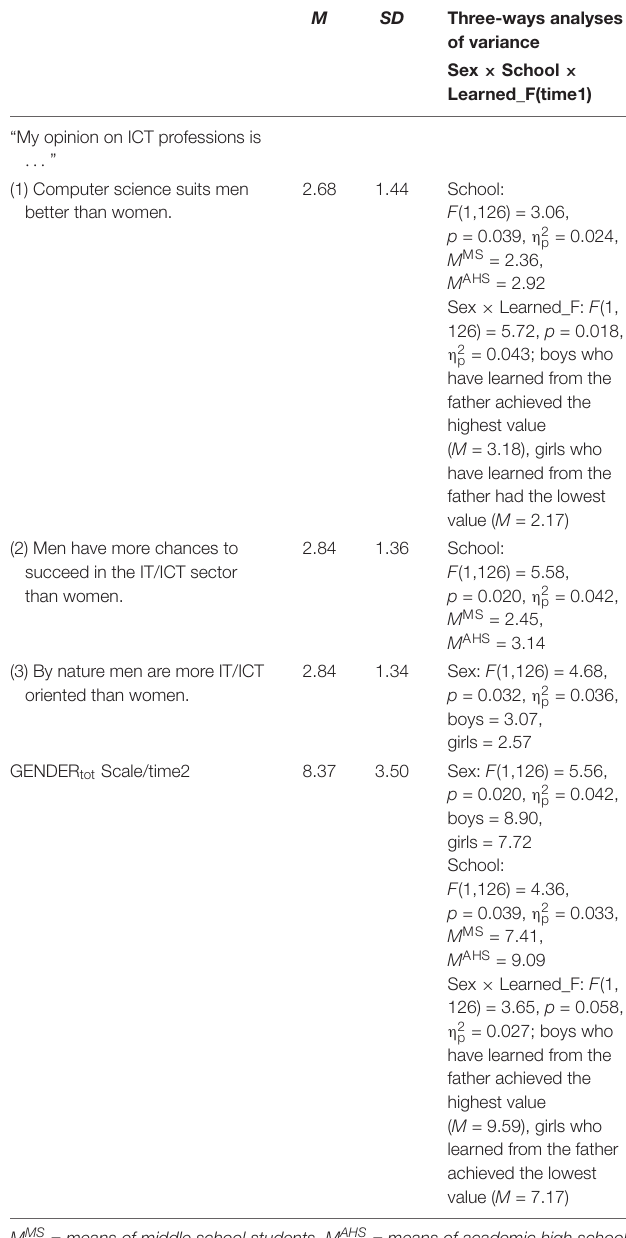
TABLE 9 | Gender Stereotypes in